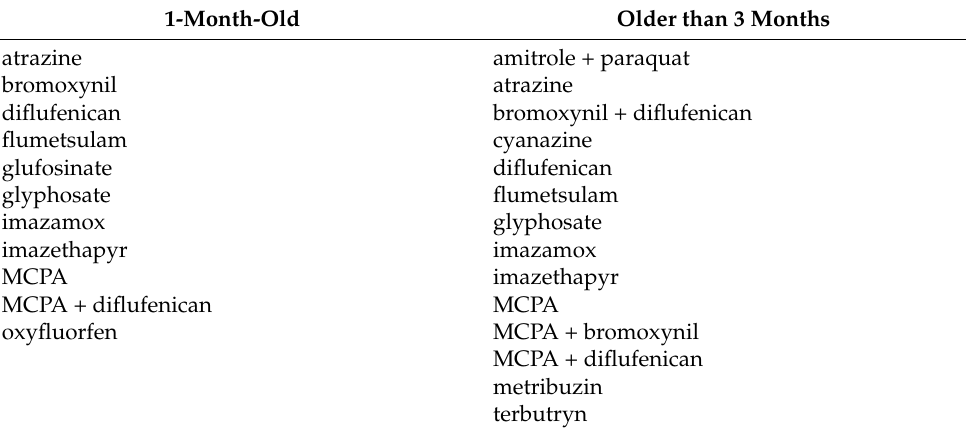
Table 1. List of herbicides evaluated in 1-month-old tedera seedlings or in tedera older than three months prior to